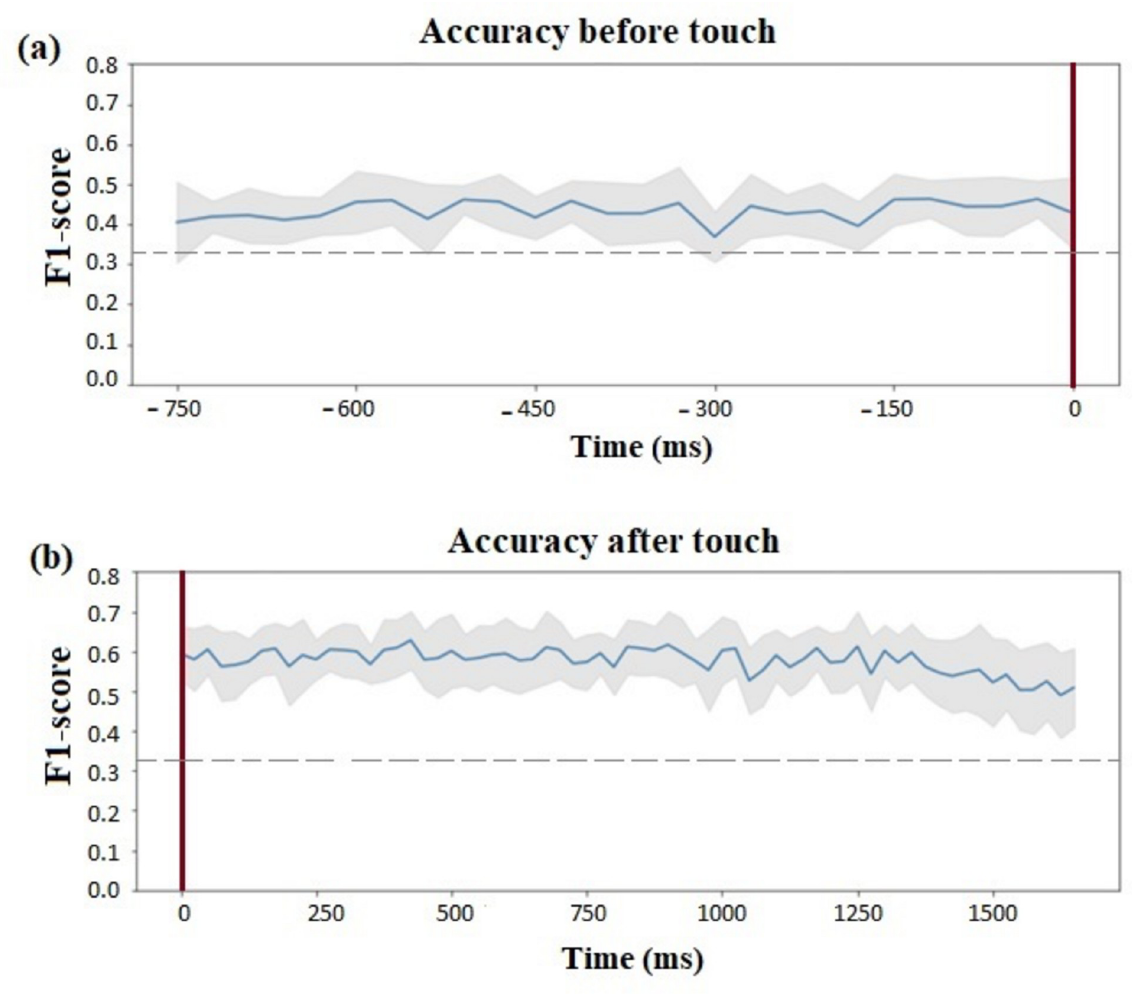
Fig 9. Sliding-window analysis of Laplacian Eigenmap dimensionality reduction and k-NN classification before touching the object (a) and after touching it (b). We used a 100 ms sliding window with a step size of 40 ms. In both panels, the onset of touching the object is designated by a vertical red line at time